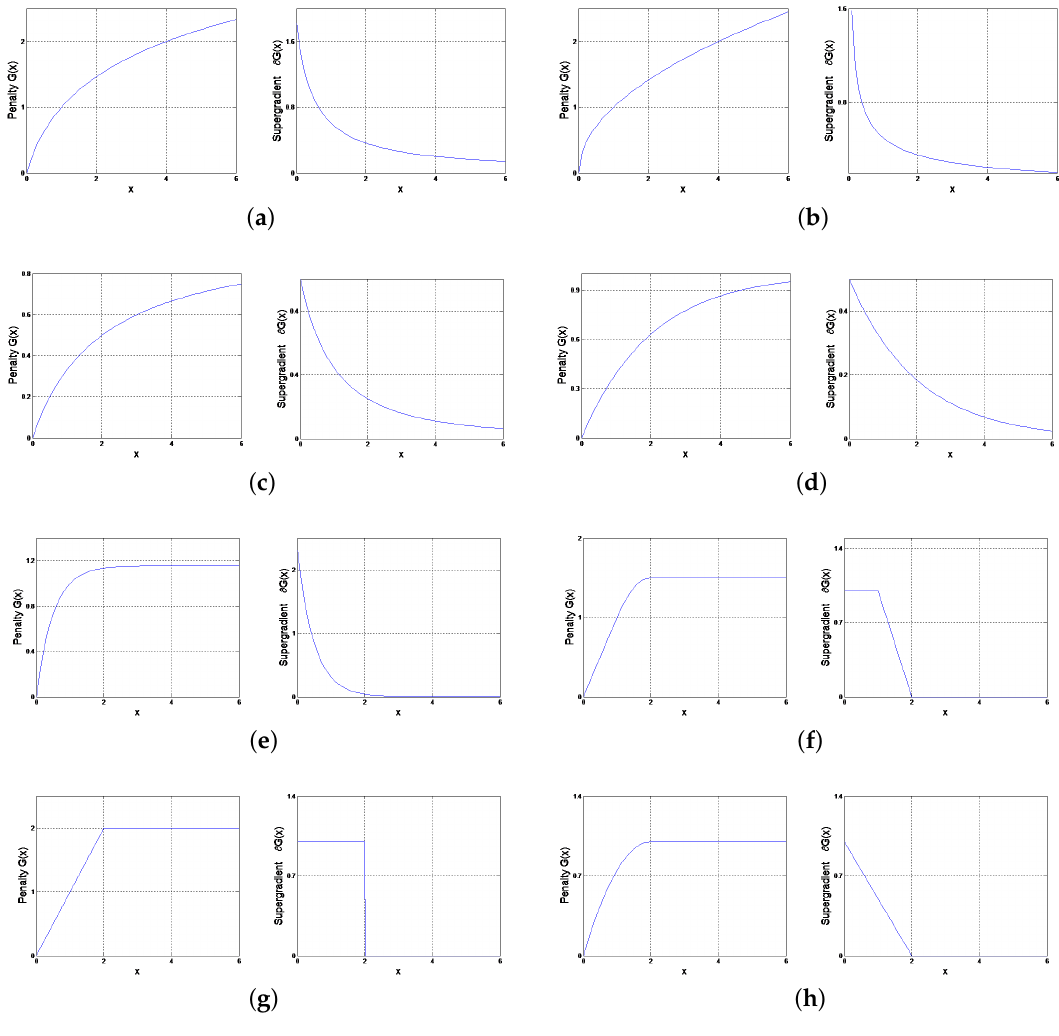
Figure 1. Some popular nonconvex surrogate functions of the (cid:96) 1 norm (left) and their super-gradients (right). ( a ) Log penalty; ( b ) (cid:96) p norm (Lp) penalty; ( c ) Geman penalty; ( d ) Laplace (Lap) penalty; ( e ) Exponential type penalty (Etp) penalty; ( f ) Smoothly-clipped absolute deviation (Scad) penalty; ( g ) Capped (cid:96) 1 (Cappedl1) penalty; ( h ) Minimax concave penalty (Mcp)